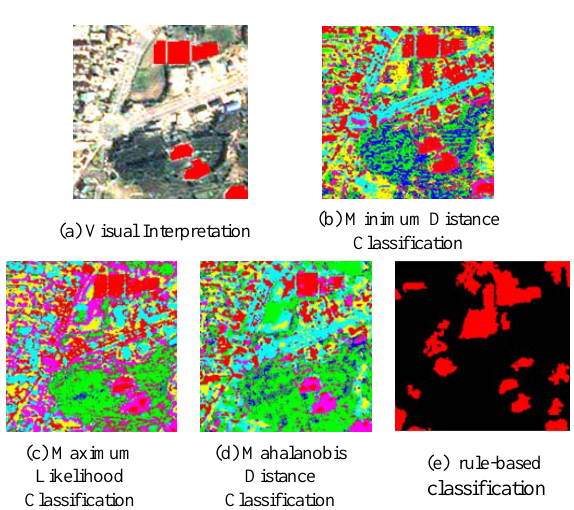
Figure 3. Classification result in downtown area